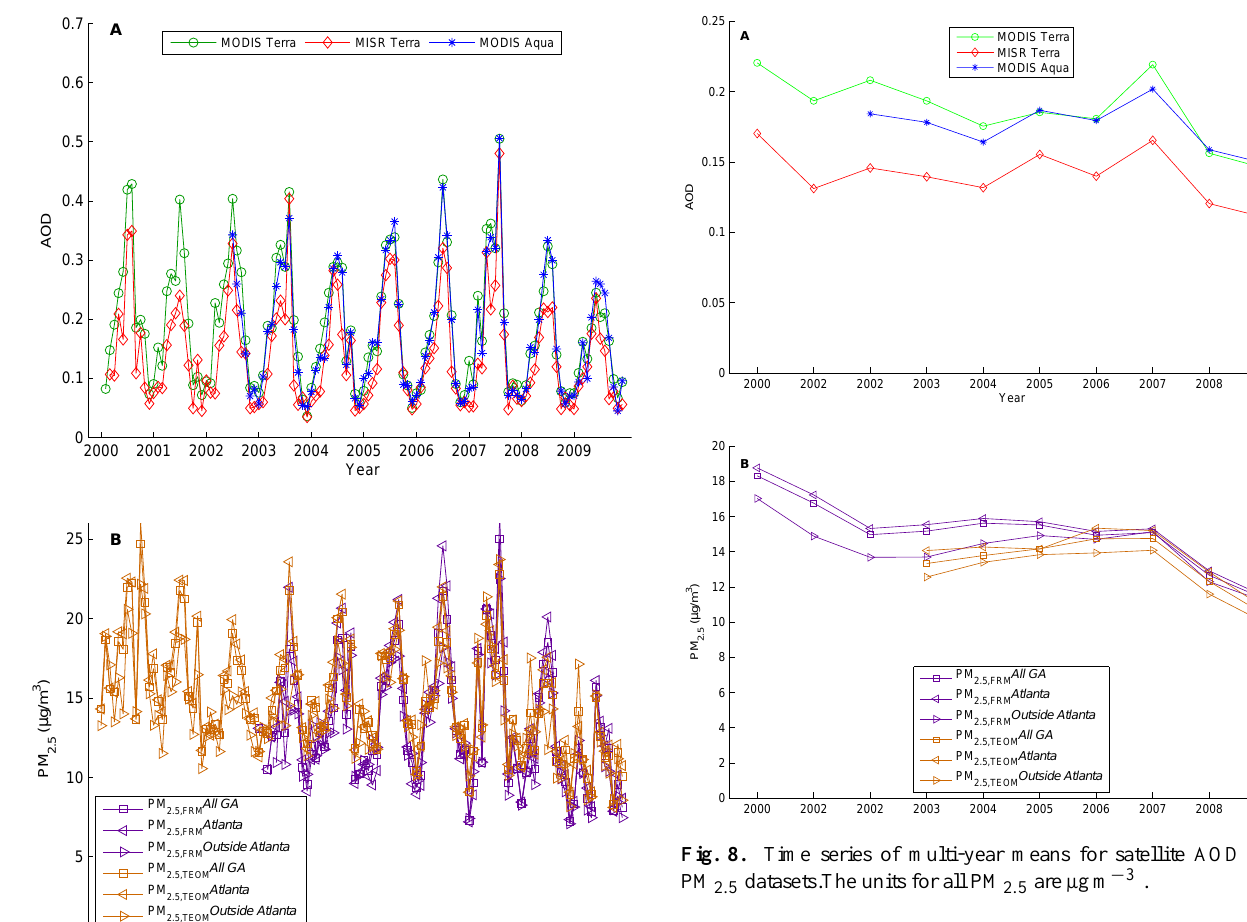
Fig. 7. Time series of monthly means for satellite AOD and PM 2 . 5 datasets. The units for all PM 2 . 5 are µgm − 3 .